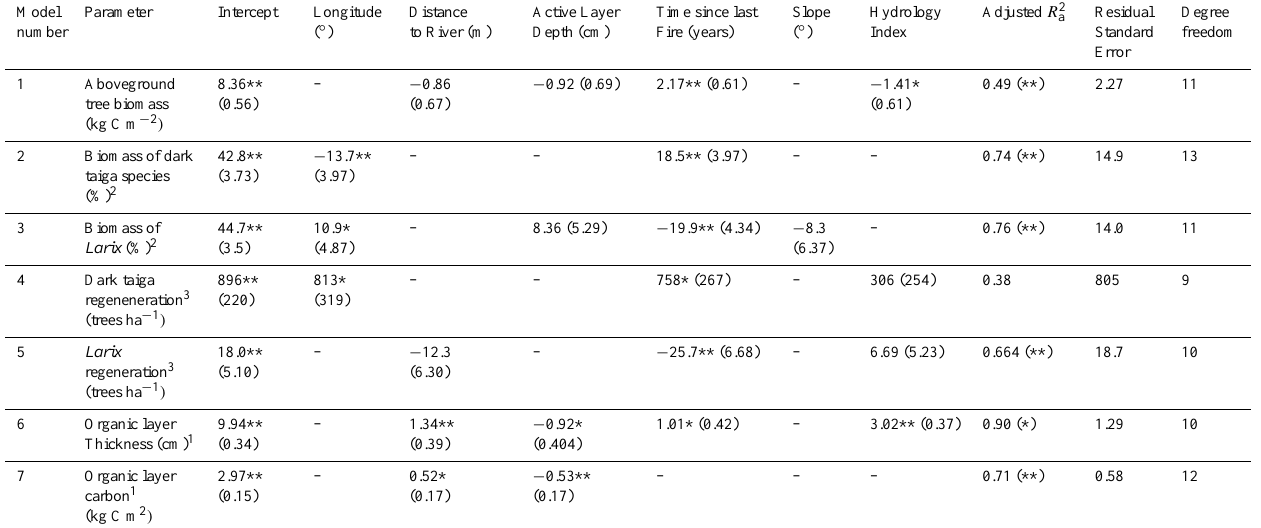
Table 5. Best candidate models for selected variables representing stand composition, biomass and organic layer carbon; standard error of estimates in brackets. Because all predictors were z-transformed prior to analysis the magnitude of the coefficients reflects the relative importance of the respective variables. Significance indicators: * p < 0 . 05, ** p < 0 . 01. Indicators for overall model significance based on the F -statistic are shown together with R 2 a